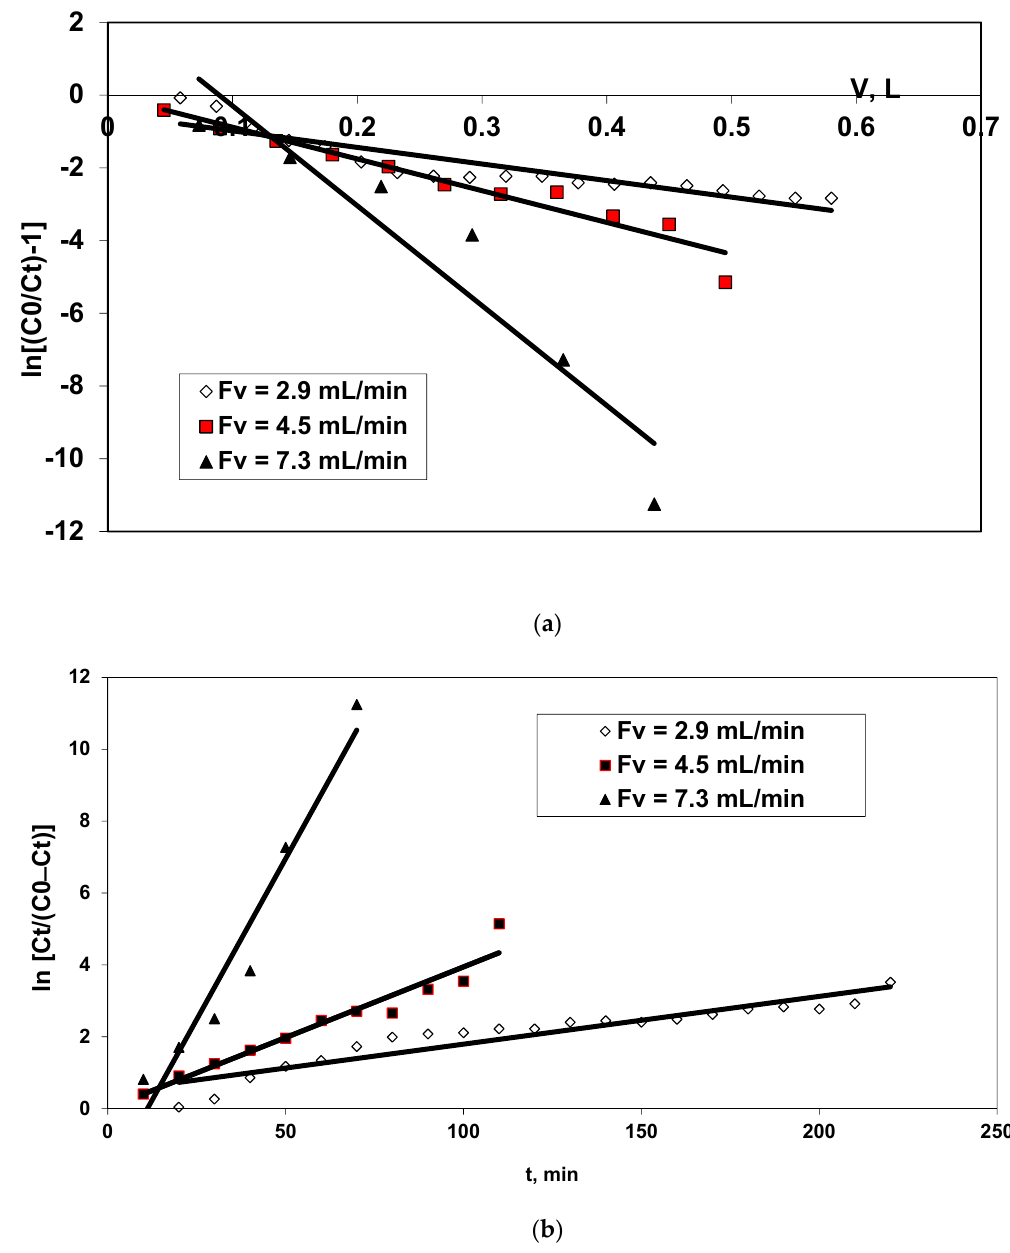
Figure 3. Graphical representation of the linearized equations of the Thomas ( a ) and Yoon–Nelson ( b ) models for biosorption in a dynamic regime. Operating conditions: T = 20 °C; C 0 = 76.72 mg/L; pH = 3. Table 3. Thomas and Yoon–Nelson models applied for BRed dye—residual Bacillus sp . biomass immobilized in an alginate biosorption system in a dynamic regime.